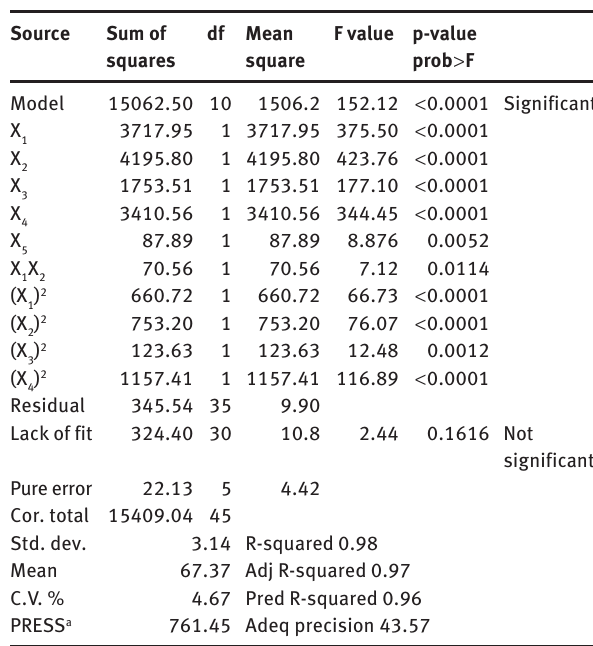
Table 2 ANOVA analysis of regression model developed for (S,S)-